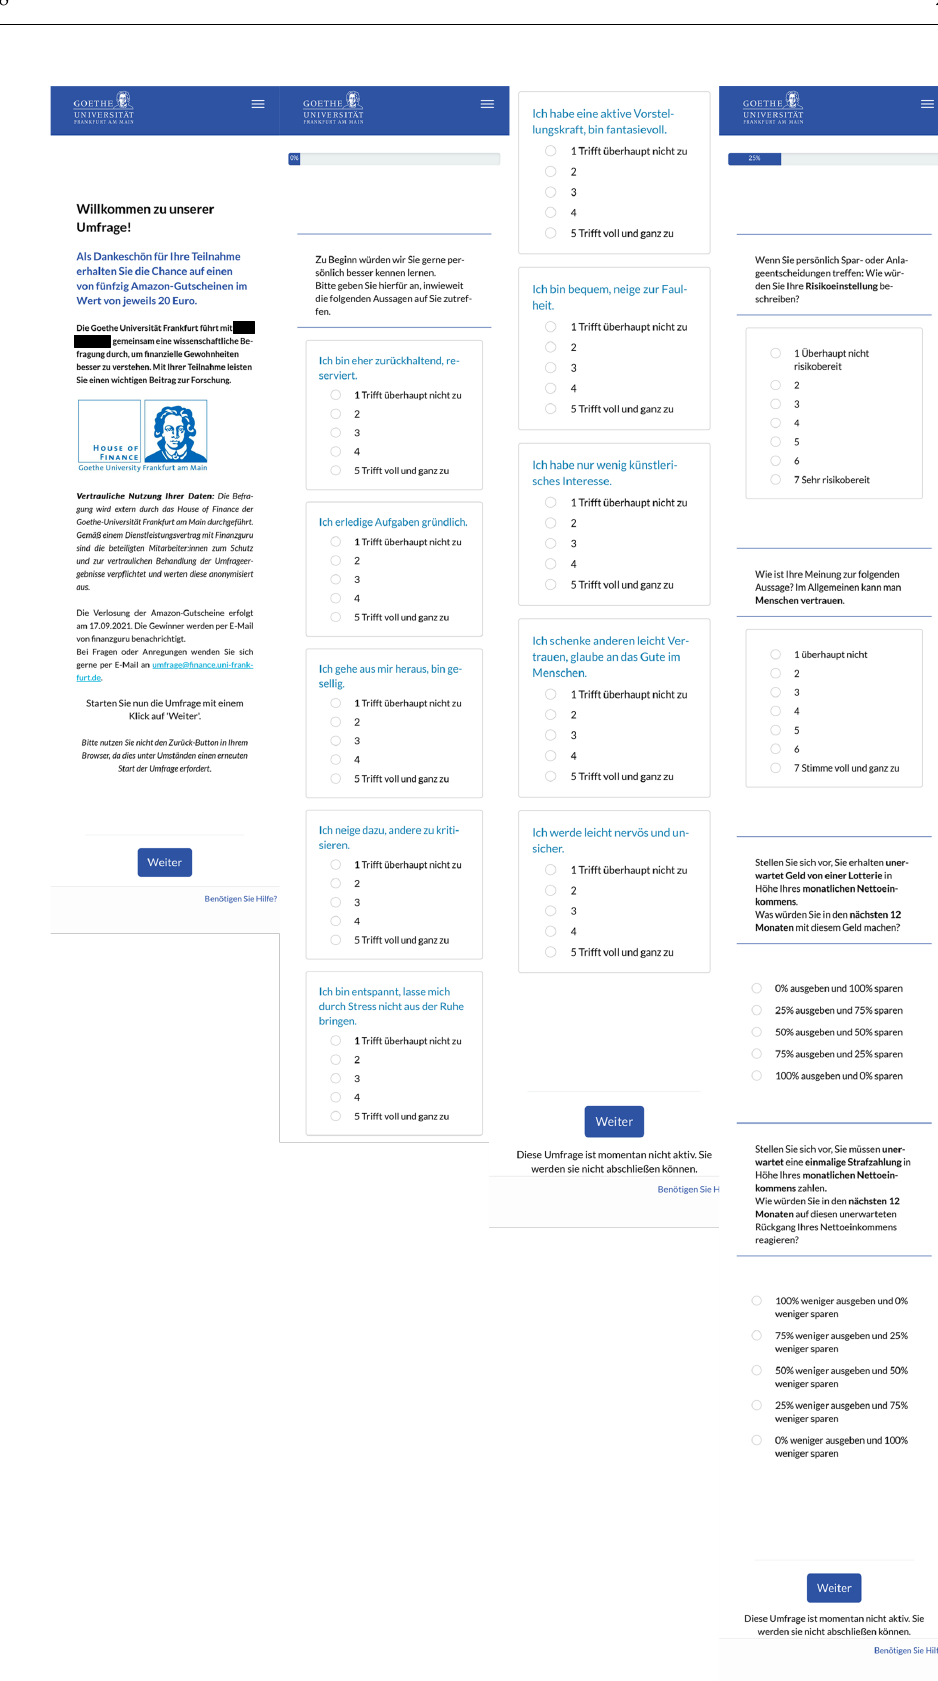
Figure A2. Survey mobile version (page 1–3). Source: Own